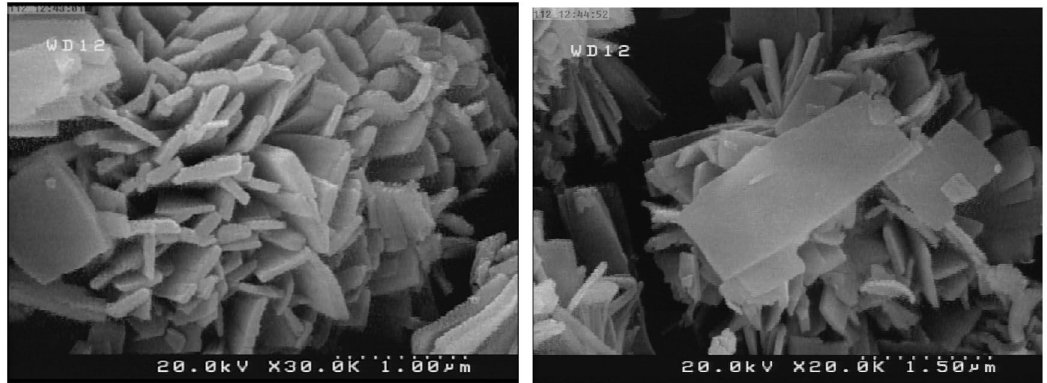
Fig. 3. The SEM image of nano-sheet complex (1), [Cd (3-bpdh)(3-bpdb) Cl